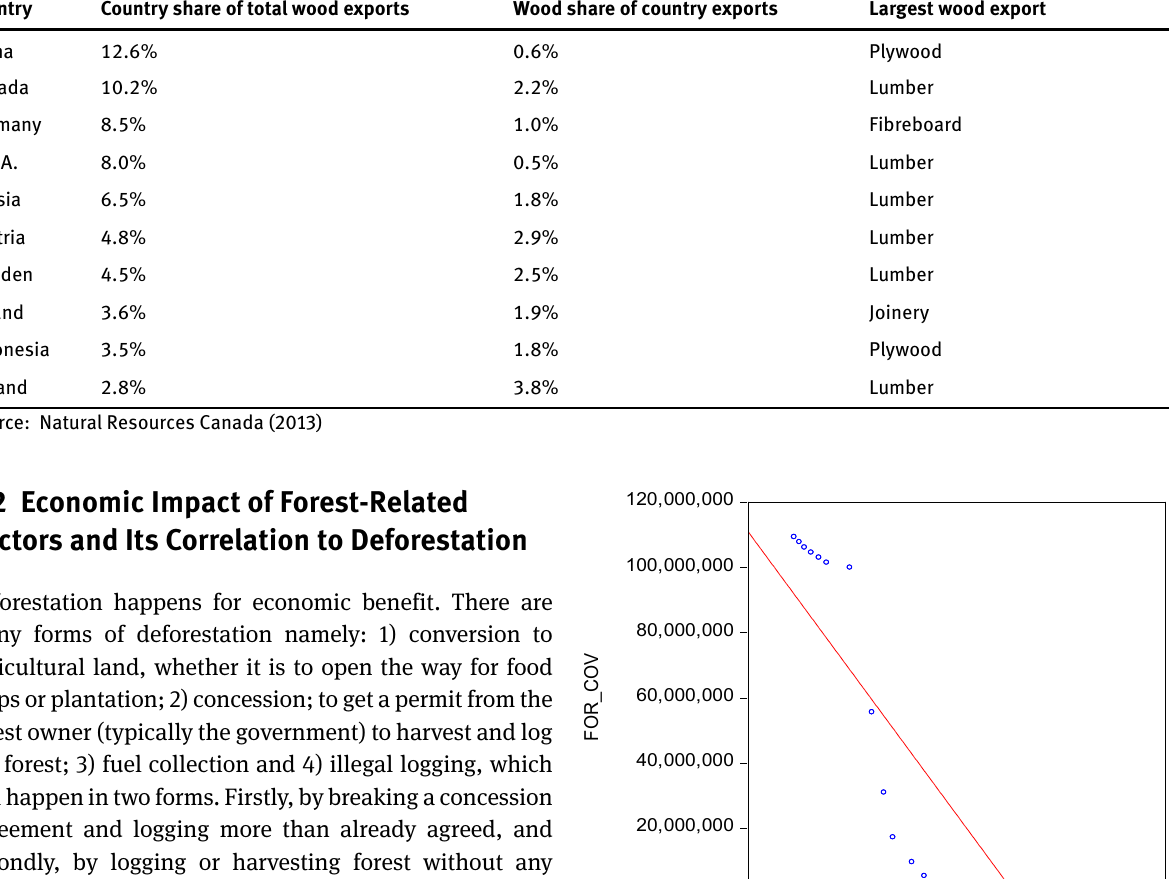
Table 4: Top10 exporting countries of wood products Country Country share of total wood